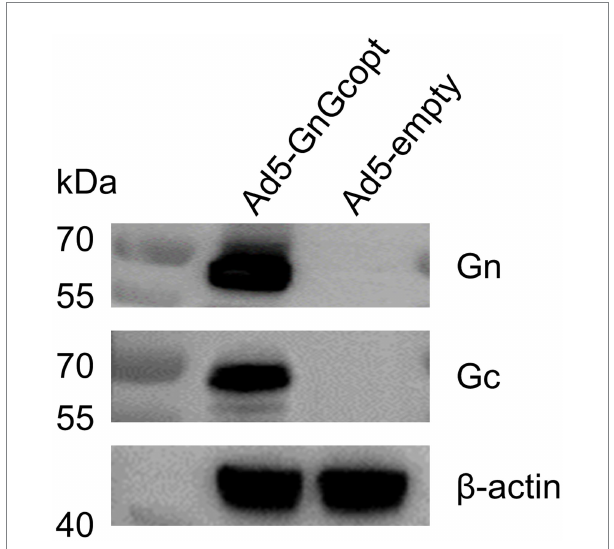
FIGURE 1 Characterization of rift valley fever virus (RVFV) vaccine Ad5- GnGcopt. Vero E6 cells were infected with Ad5-GnGcopt and Ad5- empty at a multiplicity of infection (MOI) of 10. The cells